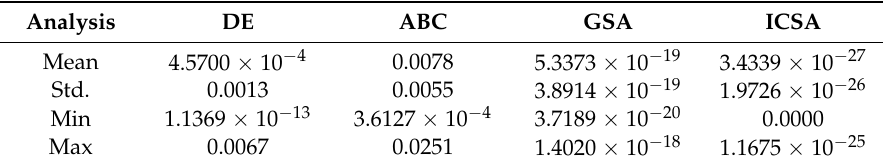
Table 5. Results of approximate circuit model ( Cos t AM ) , for motor 2.